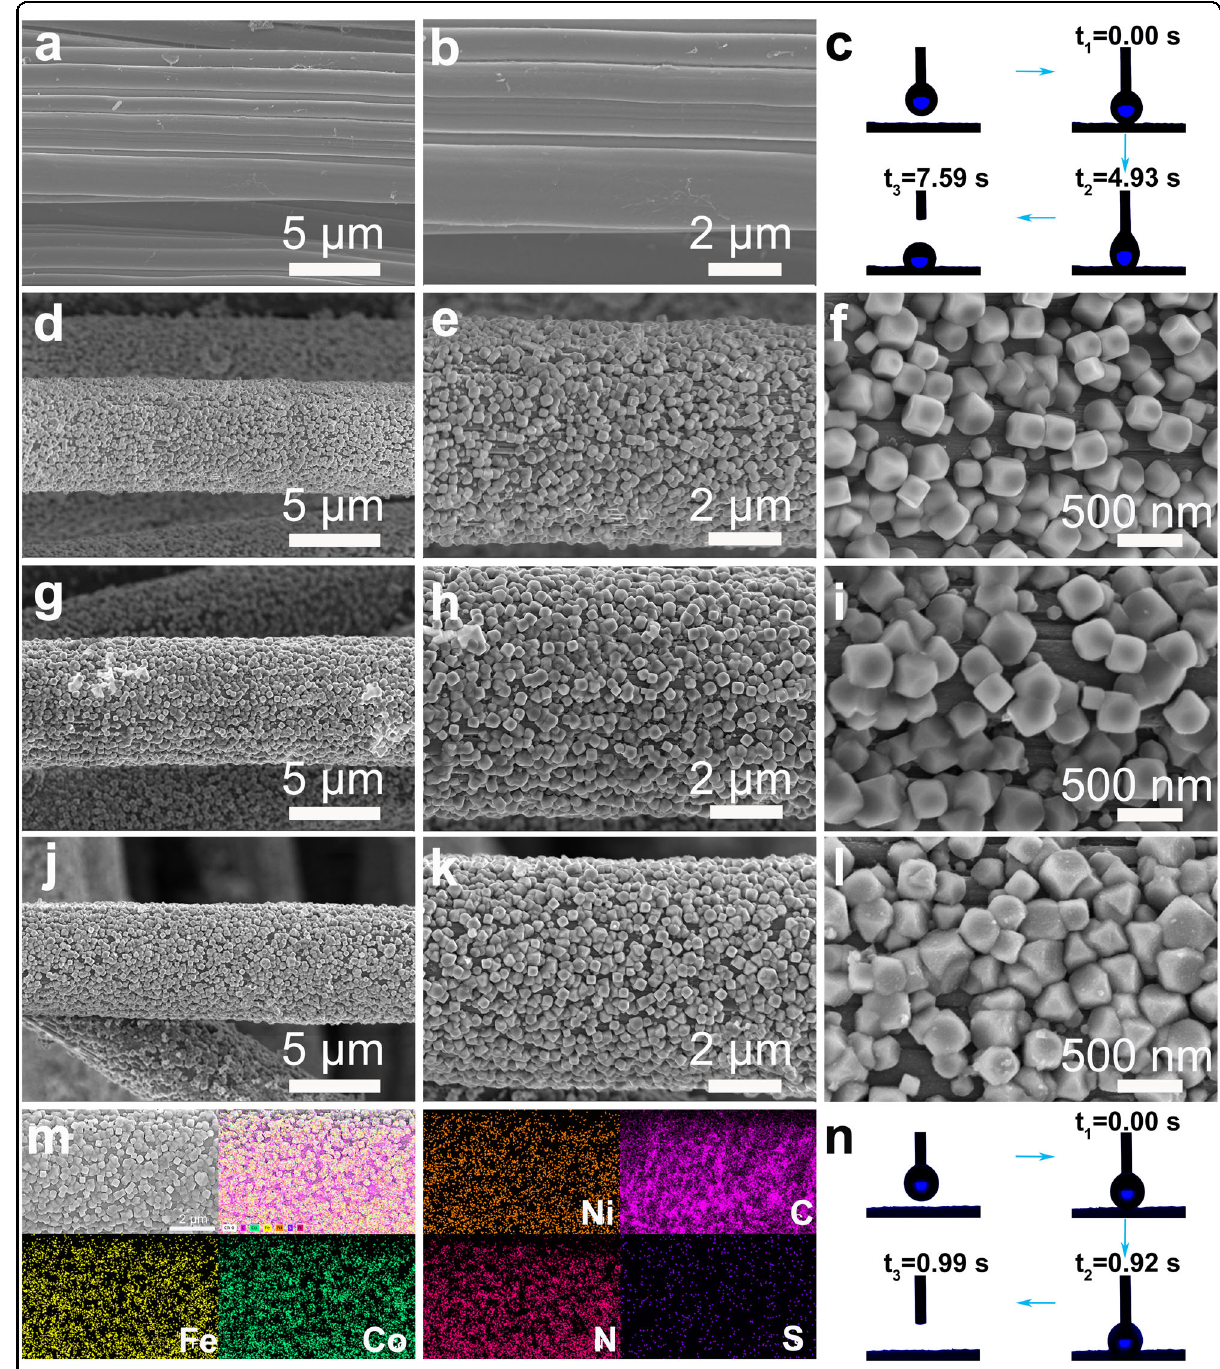
Fig. 2 Scanning electron microscopy and contact angle analyses. a Low- and b high-magni fi cation scanning electron microscopy (SEM) images of CC. c Contact angle measurements of CC. Low- and high-magni fi cation SEM images of d – f FeCoNi PBA, g – i h -FeCoNi PBA and j-l h